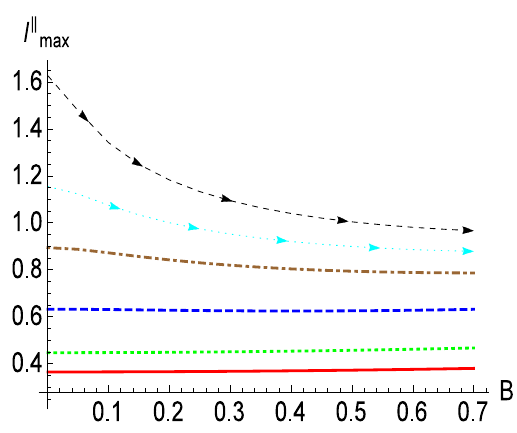
Figure 3 . ‘ k max as a function of B for var- ious c . Here ‘ c = 1 and (solid, red), (dot, green), (dash, blue), (dot-dash, brown), (arrow- dot, cyan) and (arrow-dash, black) curves cor- respond to c = 3, 2, 1, 0 : 5, 0 : 3 and 0 : 15 respec- tively. In units GeV.